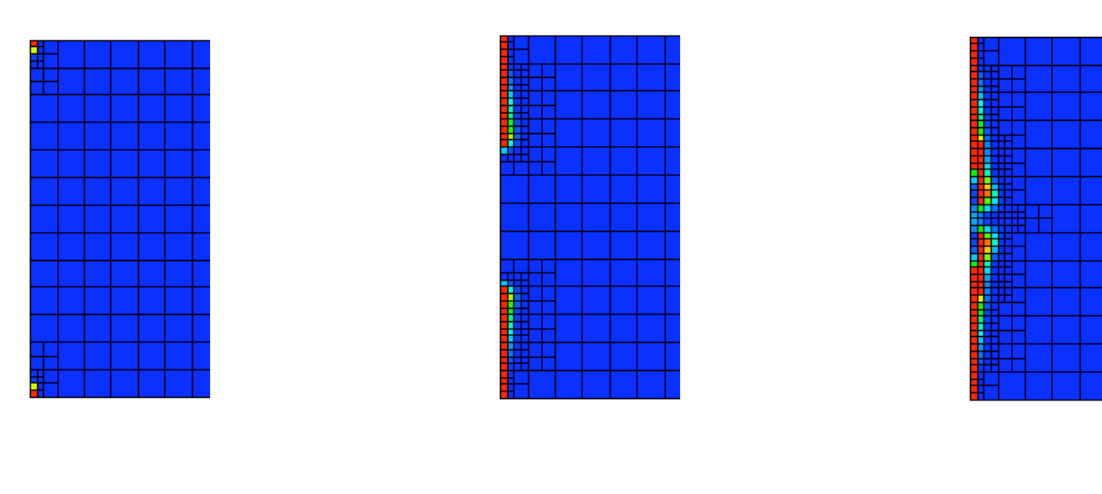
Figure 5 . Damage based refinement: from left to right, zoom-in images of the damage at the fixed-end of the bar X = 0 , at t = 88.5 µ s , t = 106.1 µ s , and t = 115.9 µ s . The damage nucleates at the corners of the bar, and progresses towards the center.